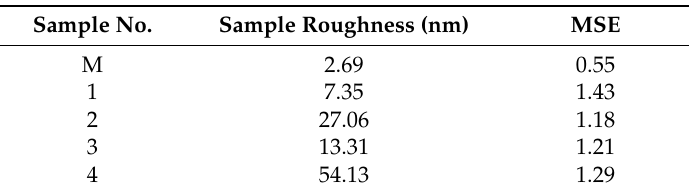
Table 2. Roughness and MSE (mean squared error) of coatings with ZnO materials modified with different silane precursors.